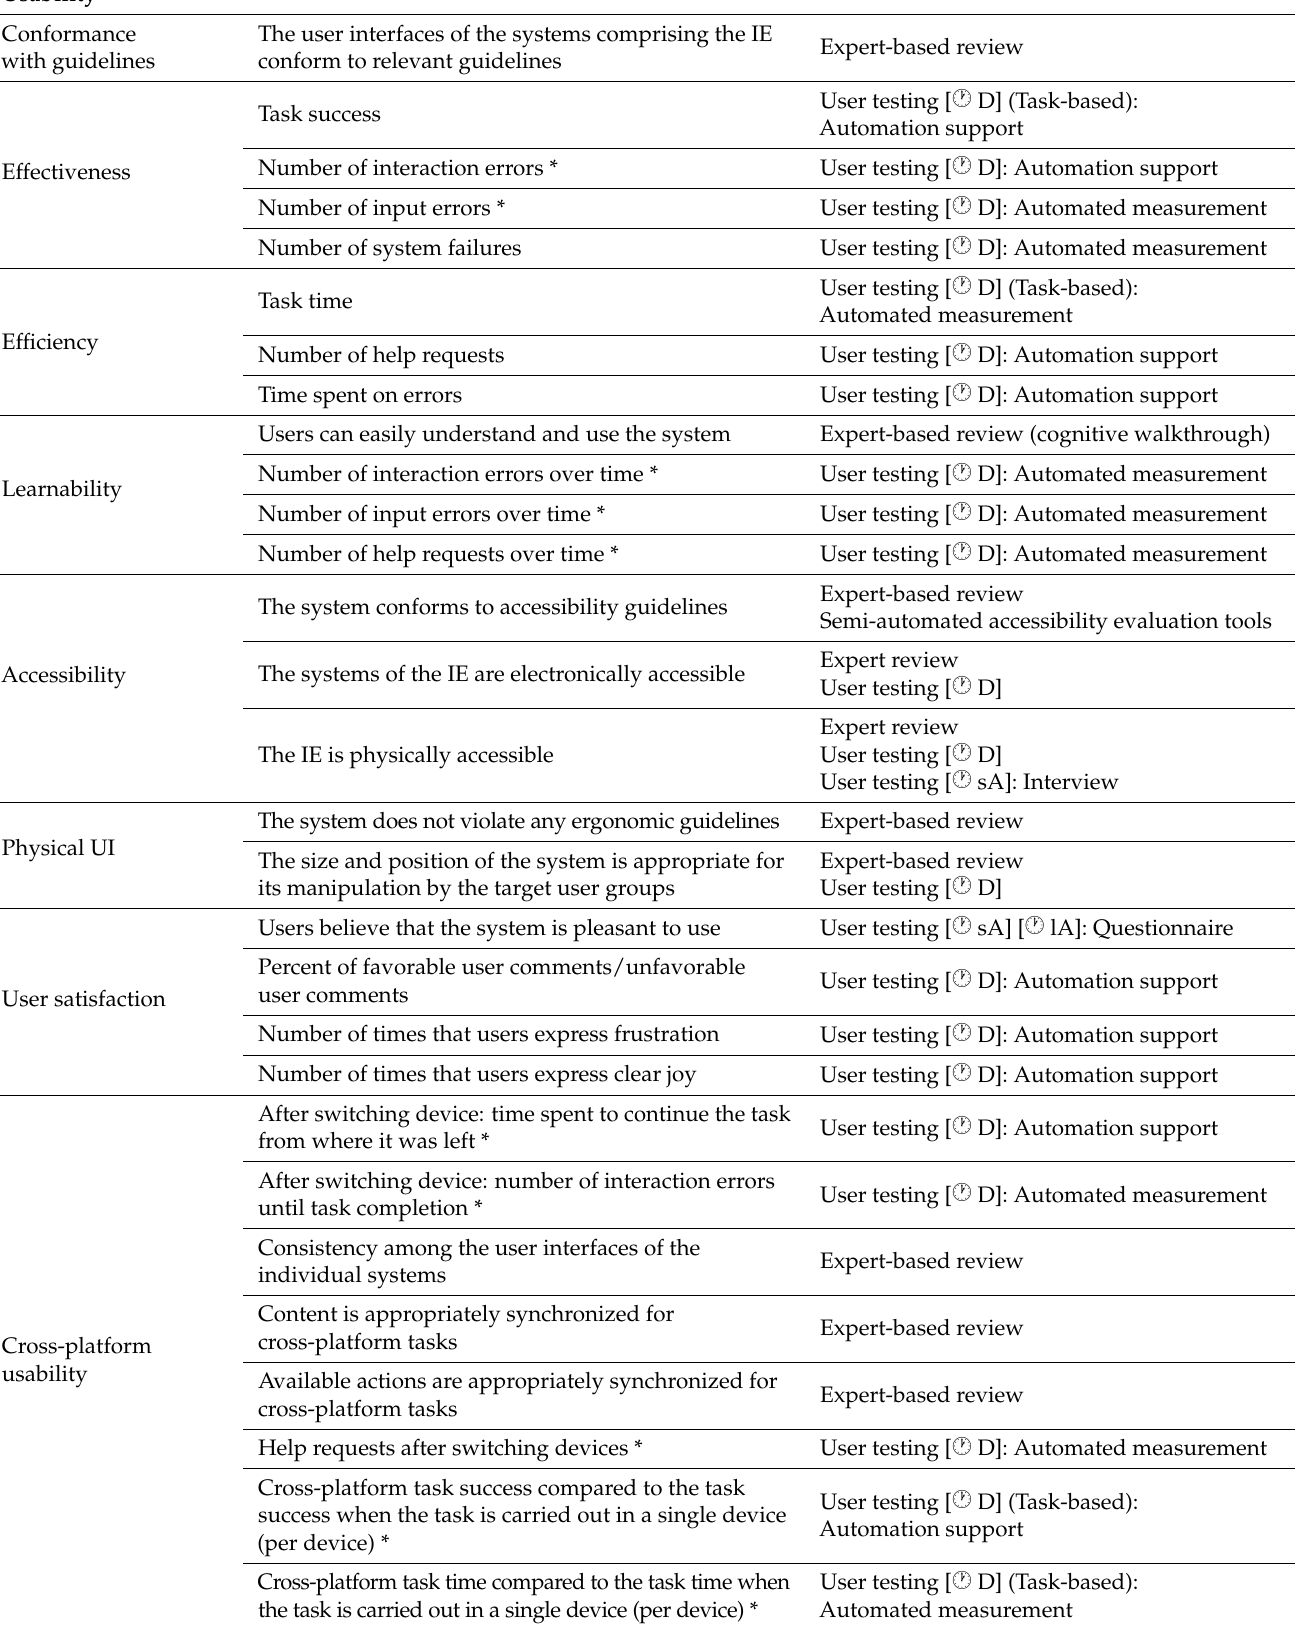
Table 1. The UXIE framework: concepts, attributes, metrics and methods. Asterisk (*) denotes metrics that are novel in the UXIE framework.